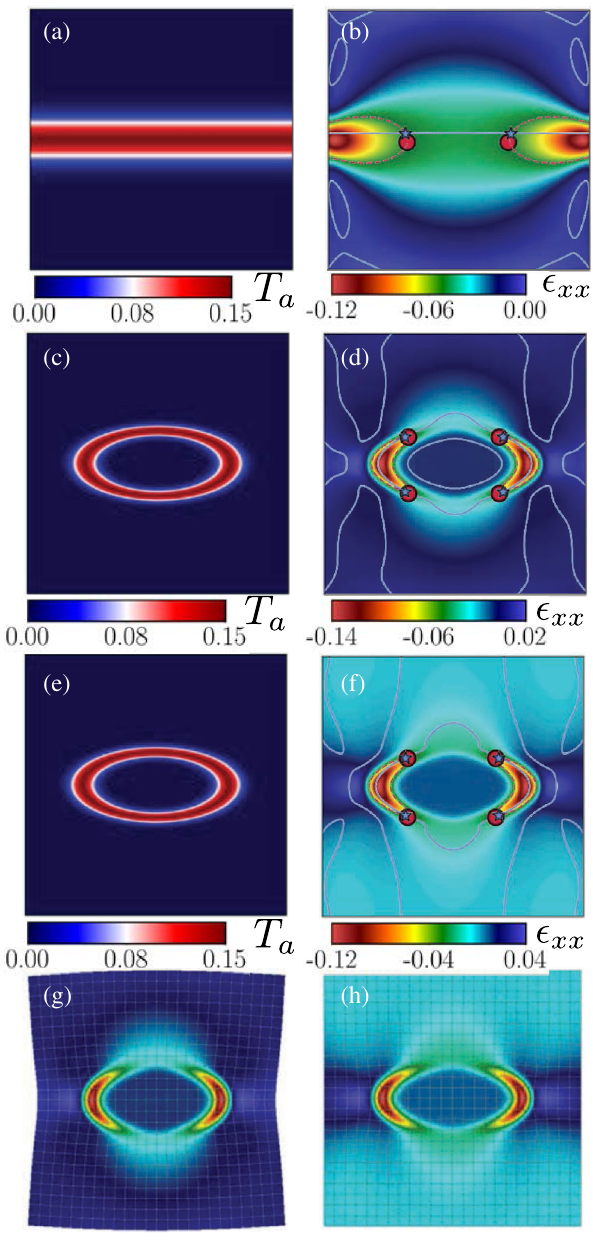
FIG. 6. Mechanism of formation of unpaired mechanical singularities in anisotropic tissue with fibers aligned along the x axis. Active tension (a) and strain ϵ (b) for a plane wave xx traveling in the þ y direction in a tissue with stress-free boundary conditions. Active tension (c) and strain ϵ (d) for a target wave xx expanding in a tissue with stress-free boundary conditions. Active tension (e) and strain ϵ (f) for a target wave expanding in a xx 0 on all u tissue with fixed boundary conditions ( u x ¼ y ¼ boundaries). Red circles and blue stars indicate the location of phase singularities calculated by the Hilbert and contour-inter- section method as in Figs. 4 and 5, respectively. (g) and (h) show the same strain patterns as (d) and (f), respectively, in deformed